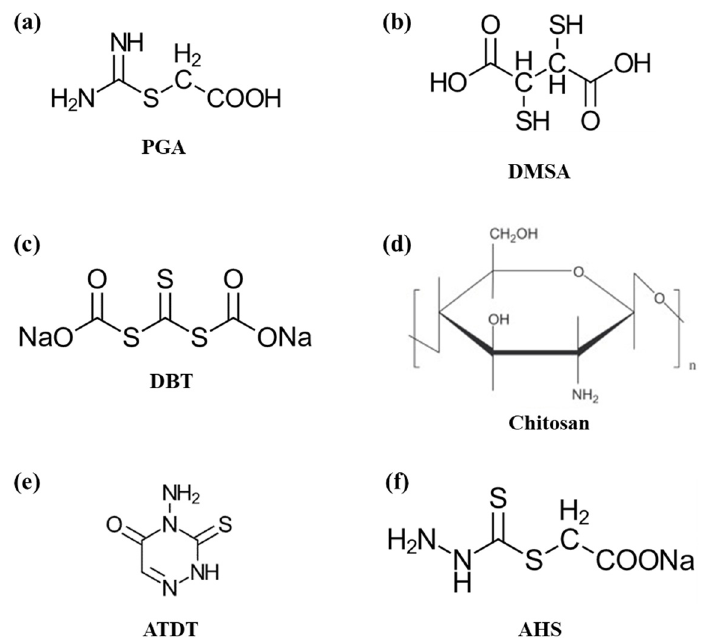
Figure 9. Molecular structure of organic depressants: ( a ) pseudo-glycolythiourea acid (PGA), ( b ) 2,3-disulfanylbutanedioic acid (DMSA), ( c ) disodium bis (carboxymethyl) trithiocarbonate (DBT), ( d ) chitosan (reprinted with permission from Crini and Badot [65], copyright (2008) Elsevier), ( e ) 4-amino-3-thioxo-3,4-dihydro-1,2,4-triazin-5(2H)-one (ATDT), and ( f ) acetic acid-[(hydrazinylthioxomethyl)thio]-sodium